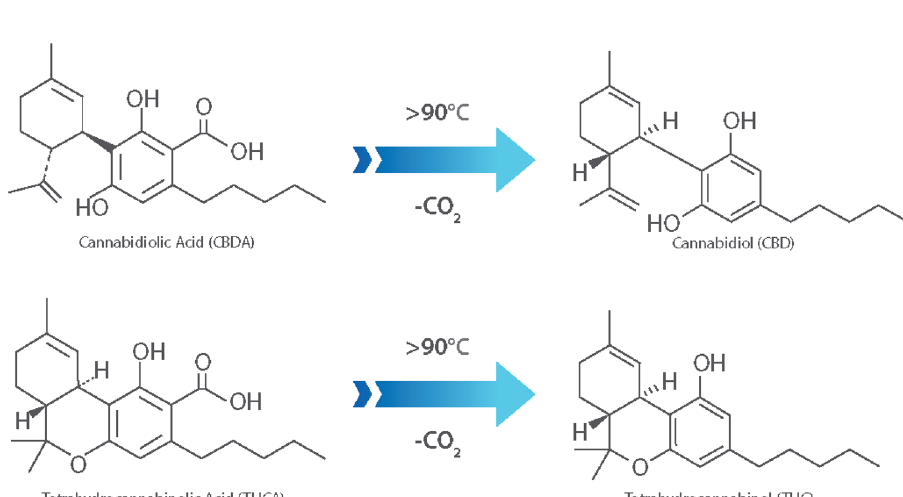
Fig. 1 Reverse HPLC results visualizing CBDA, CBD, THCA, and THC concentrations as absorbance units following hemp homogenization (green), 90 C heating of sample (black), and no sample preparation (blue)